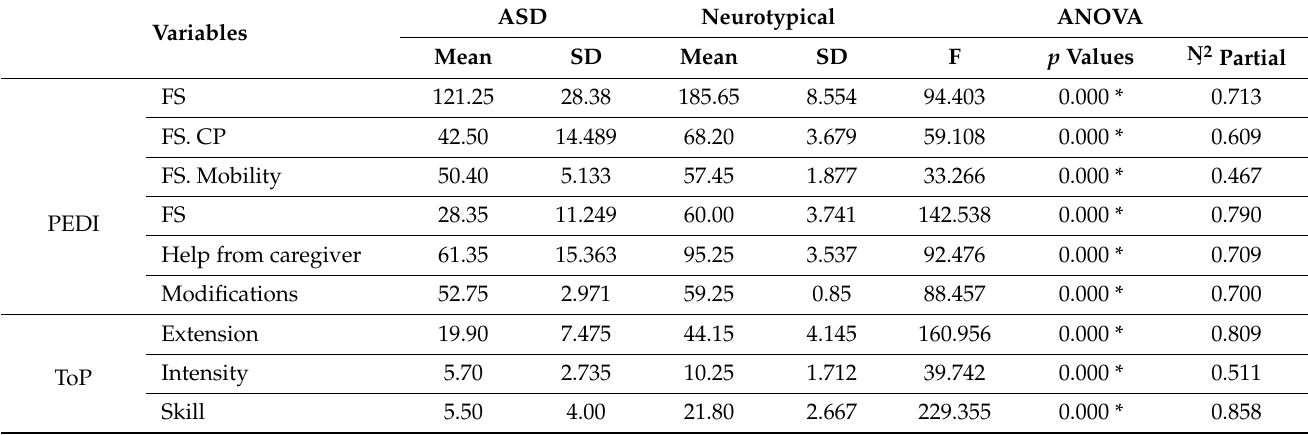
Table 3. Results of the differences between children with TEA and neurotypical children on the PEDI and the ToP scale. Table 1. Data relating to the analysis of the quantitative variables of both groups. Variables